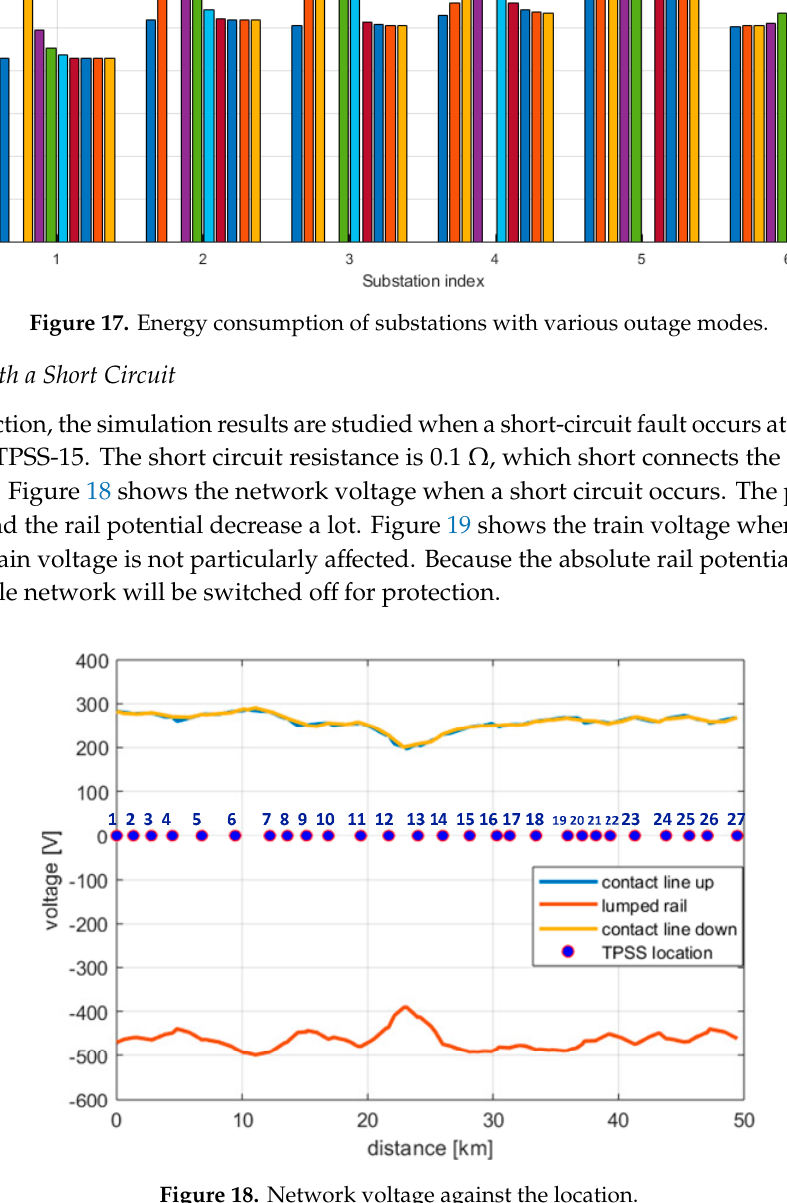
[b] Figure 16. Train voltage against location: ( a ) Normal operation; ( b ) TPSS-13 is switched off. 4.5.2. Energy Consumption The impact of TPSS outage on the network energy consumption is evaluated in this section. The scenarios when one TPSS is switched off were simulated for a one-hour operation. The headway time was 120 s. Figure 17 compares the energy consumption of six substations with various outage modes, including a no outage mode and one of the first nine TPSS outages. When the TPSS is switched off, the energy consumption for that TPSS is zero. The results denote that the network is capable of supplying enough tractive power to the trains when one of the TPSS is switched off. The following comments can be made by comparing the energy consumption when one TPSS is switched off: 1.